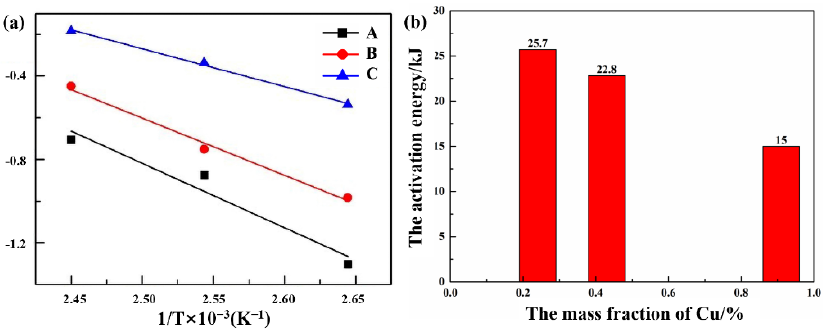
Figure 8. The ( a ) relationship between ln(k) and (1/T), and ( b ) the calculation of the chemical activation energy of aging precipitation reaction by ln(k) − (1/T).